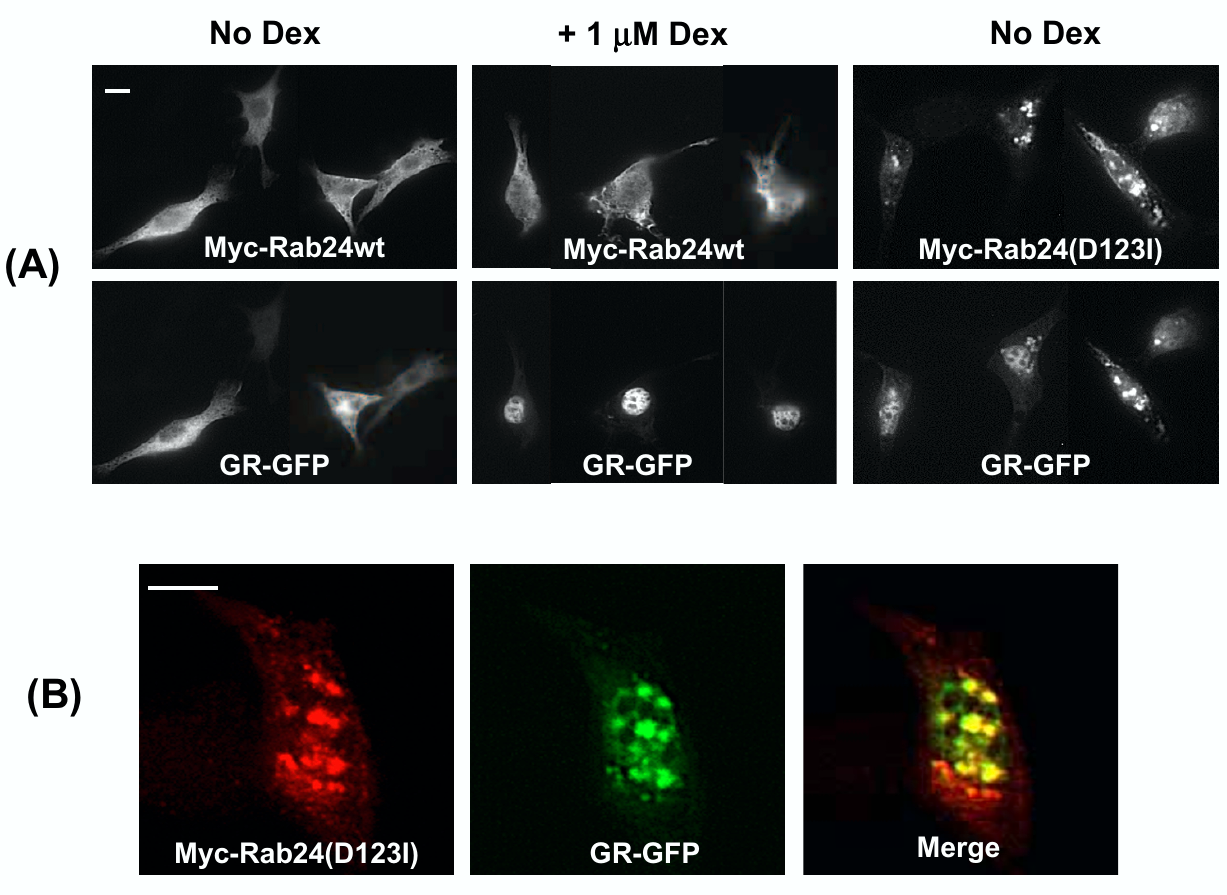
Figure 6 Effects of Rab24 wt and Rab24(D123I) on nuclear translocation of glucocorticoid receptor. (A) 3T3 cells express- ing GR-GFP with mycRab24wt show predominant cytoplasmic localization of both proteins in the absence of Dex (left panels). After 10 min incubation with 1 (cid:3) M Dex, most of the GC-GFP is within the nucleus in cells expressing Rab24wt (center panels). When GR-GFP was co-expressed with mycRab24(D123I) in the absence of steroid, much of the GR-GFP was localized to inclusion bodies containing the Rab24 mutant (right panel). Identical results were observed when 1 (cid:3) M Dex was added (not shown). (B). Higher magnification shows extensive co-localization of myc-Rab24(D123I) (red) with GR-GFP (green) in nuclear inclusion bodies. The bar represents 10